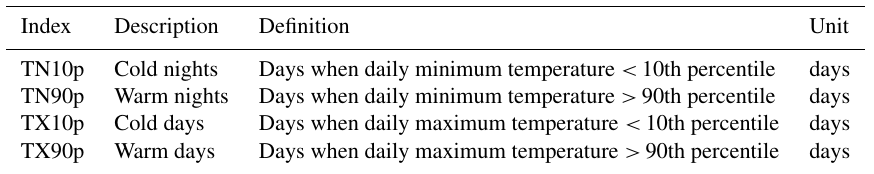
Figure 8. Annual average series of maximum (a) and minimum (b) temperatures in Tianjin from 1887 (1891 for minimum) to 2019 based on newly constructed and raw daily data (after quality control and extension), correspondingly with annually averaged data based on the interpolated series from monthly BE (1873–2019) and CRU TS4.03 (1901–2018) and station series from GHCN v3 (1905–1990) for Tianjin Station. Table 5. Definition of temperature extremes (Zhang et al., 2011). Days with maximum or minimum temperature above the 90th and below the 10th percentiles are relative to the reference period of